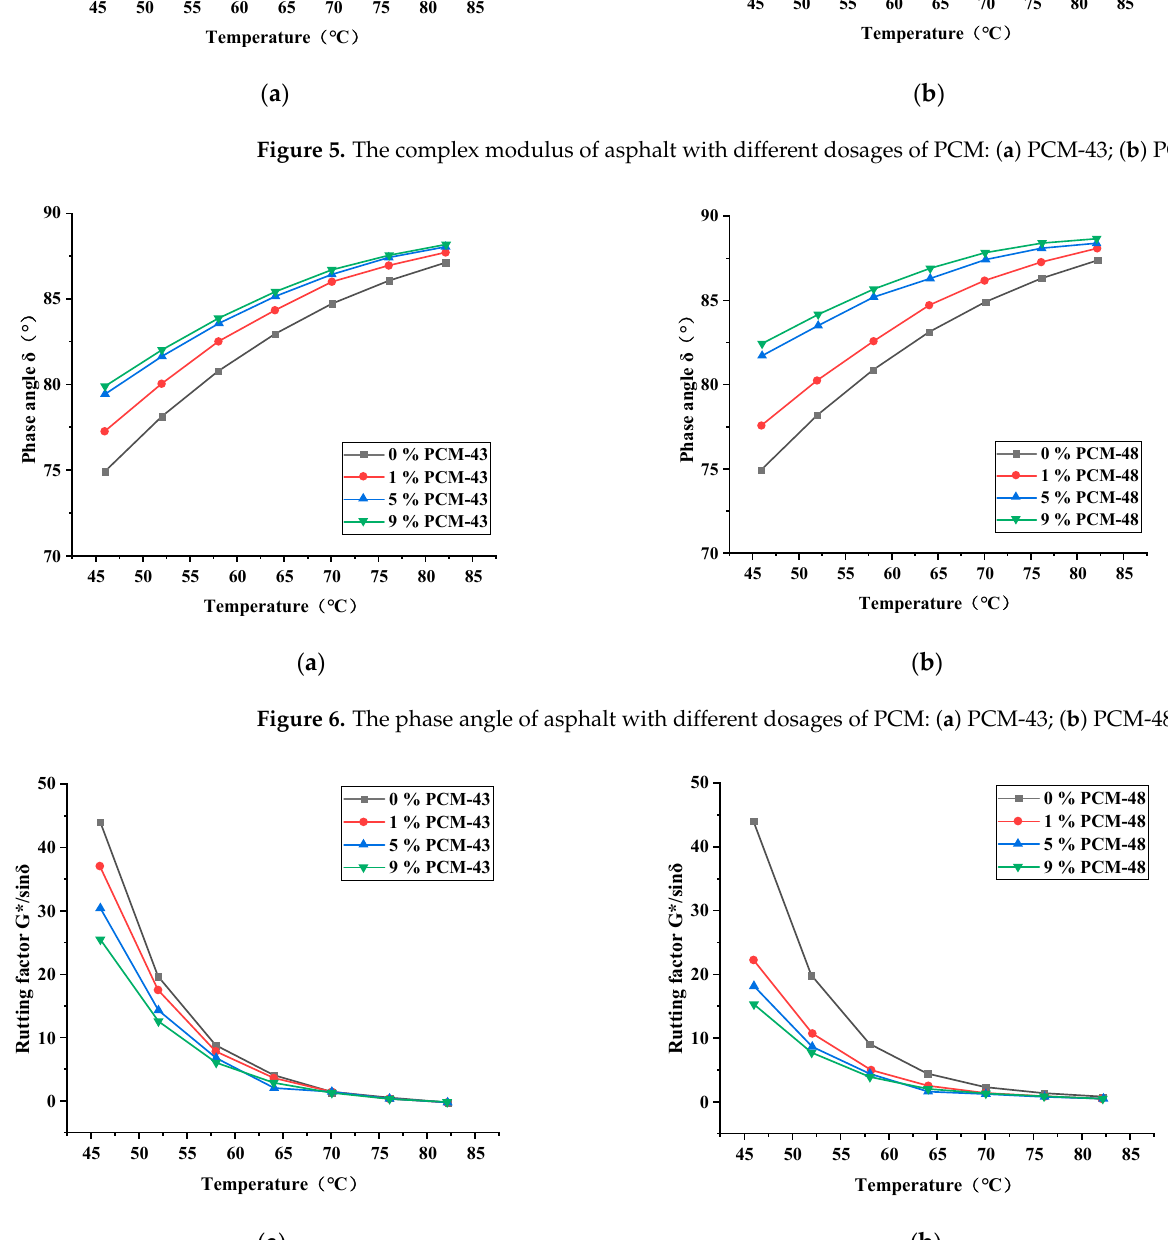
( b ) Figure 8. Temperature adjustment performance of PCM asphalt: ( a ) PCM-43; ( b ) PCM-48. It can be seen that two phase-change materials can both slow down the heating of asphalt to a certain extent in Figure 8. As the amount of phase-change materials increases, heating delaying is better. It can be found that the heating rate of all samples is almost the same in the initial heating stage. When approaching the phase transition point, the tem- perature difference gradually appears for the different dosages of PCM. Moreover, the temperature difference shows a trend of gradual expansion with the increase of PCM dos- age. The maximum temperature difference between the asphalt with 9% PCM-43 and base asphalt is 6 °C, while the maximum temperature difference between the asphalt with 9% PCM-48 and base asphalt is about 4 °C. In the previous DSC test, the enthalpy of PCM-43 was about 210 J/g, while the enthalpy of PCM-48 was only 120 J/g. The former is almost